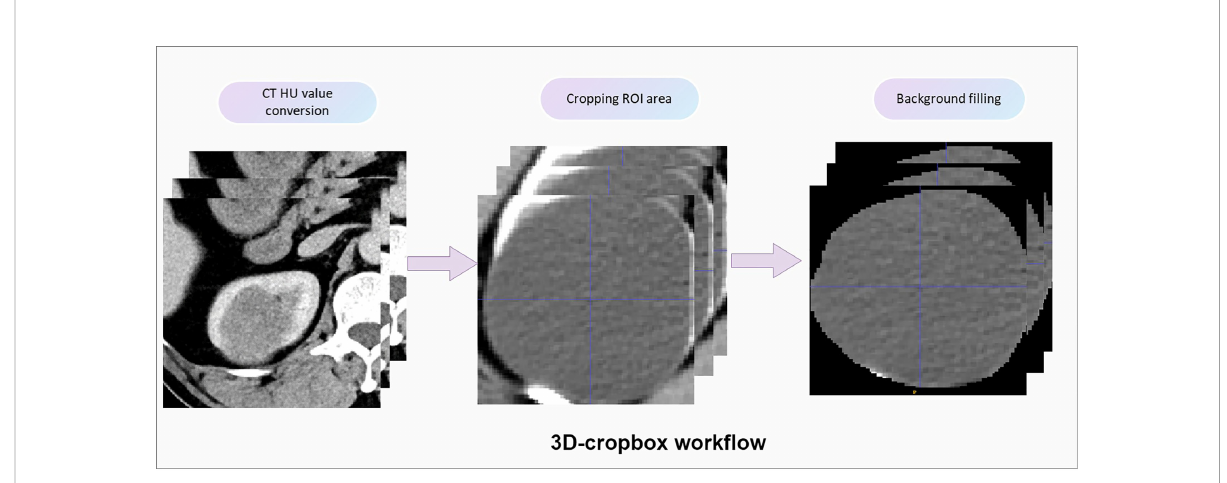
FIGURE 2 Detailed work fl ow of the 3D-cropbox. To assure that deep learning features retrieved from the 3D-cropbox are entirely tumor characteristics, the area outside the ROI will be fi lled with